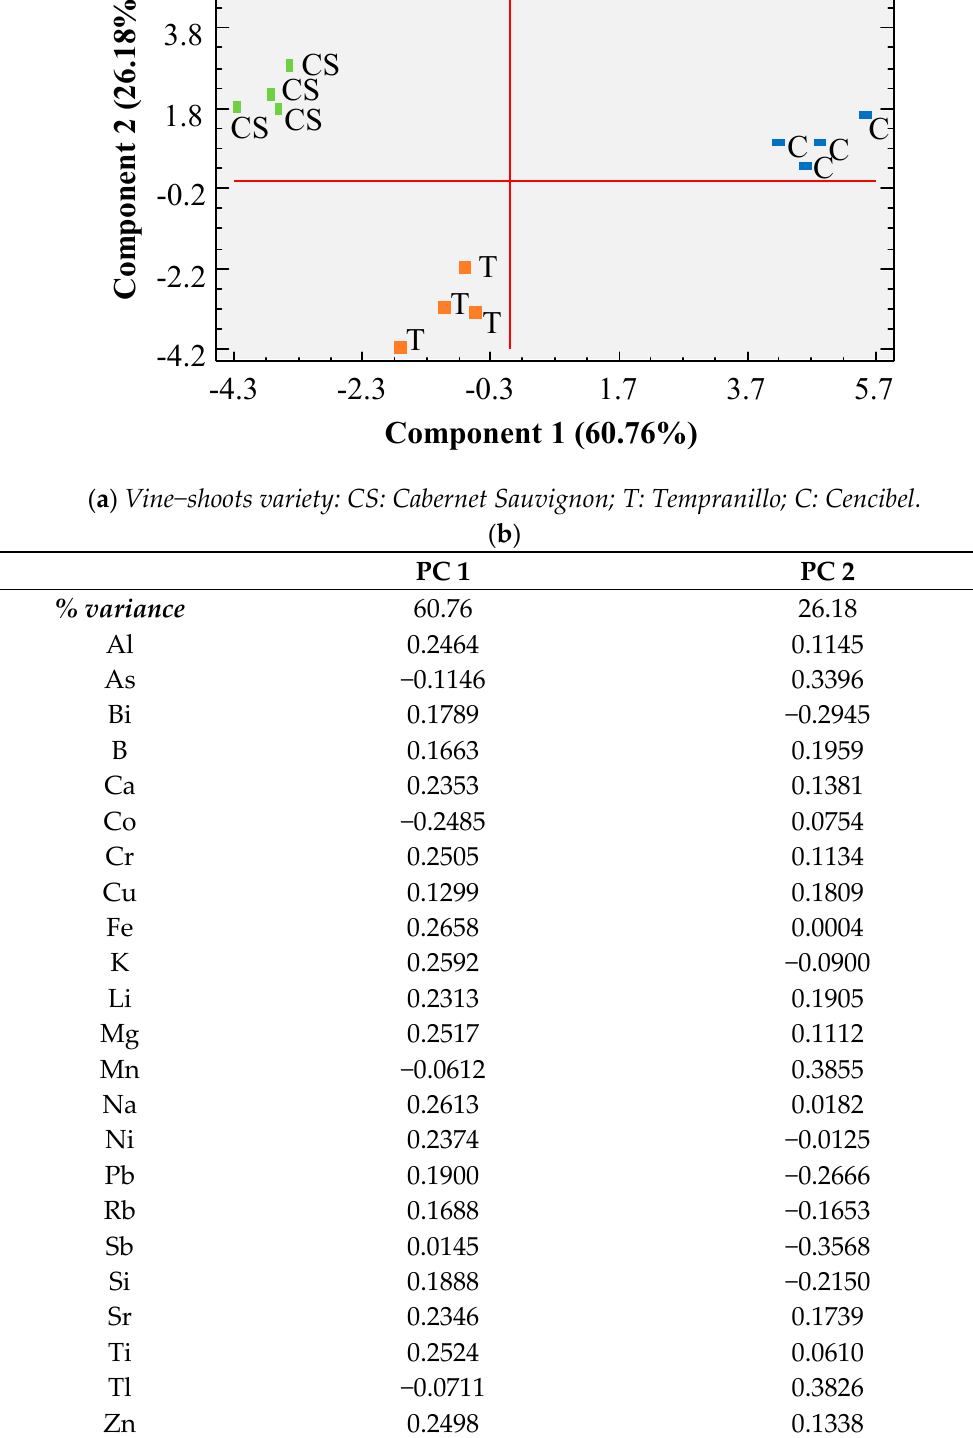
Figure 2. Principal component analysis (PCA) results carried out with mineral composition. ( a ) Projection of wine samples in the plane formed by the two main components; ( b ) weights of the variables in the first two principal components.